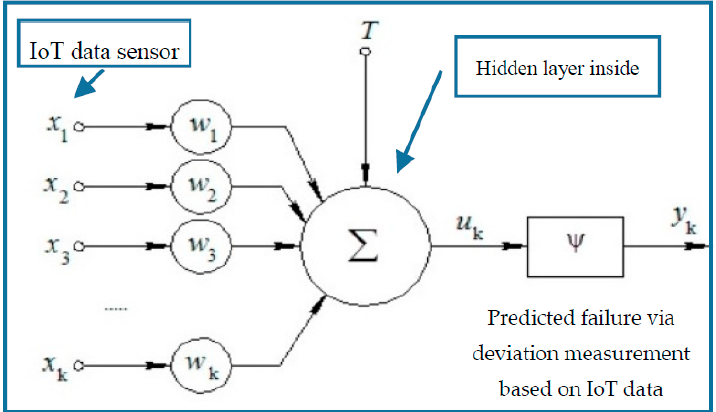
Figure 21. The structure of the neural element.